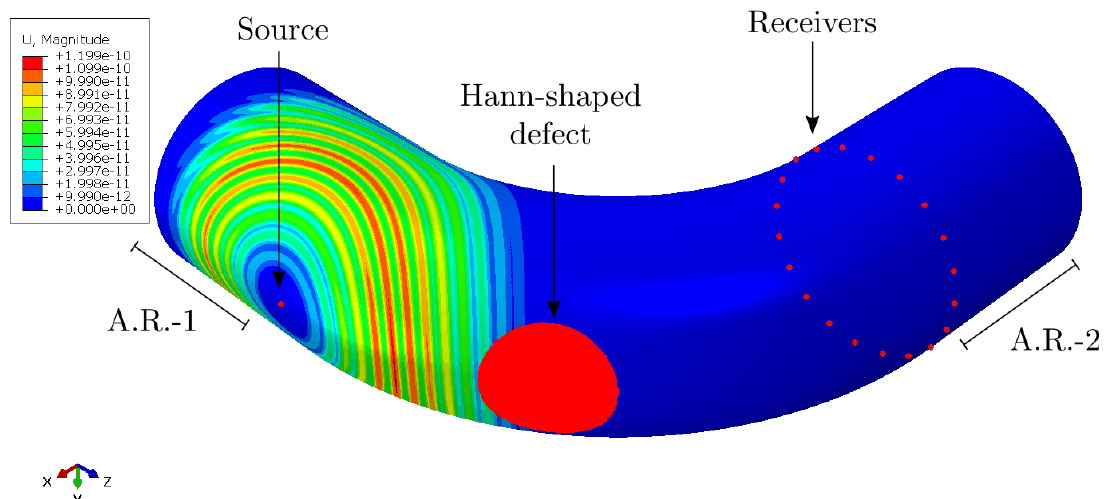
Figure 6. Geometry of the pipe bend simulated in ABAQUS for the extrados case with a Hann-shaped defect, absorbing regions (ARs) 1 and 2, and displacements of the propagating waves shown at 100